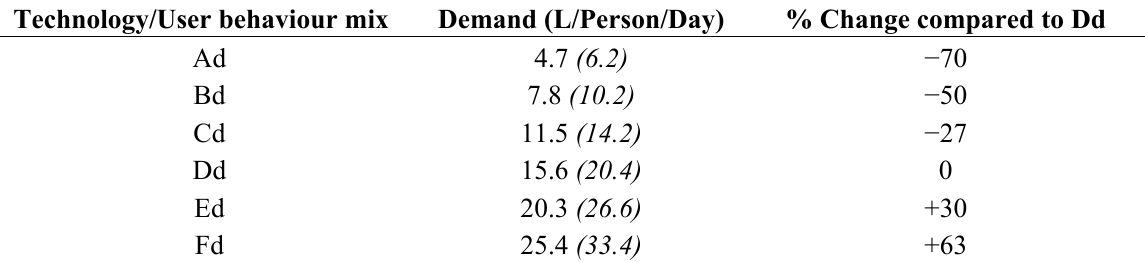
Table 7. Office demands achieved through changes in user behaviour alone: “Technological efficiency” unchanged: ( Italics show where water use by females differs from that of